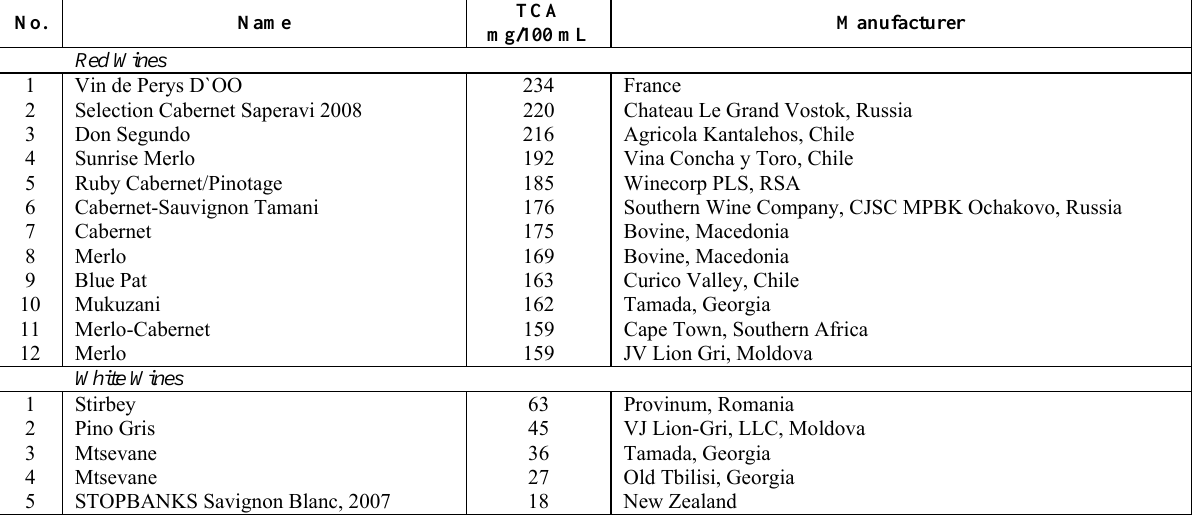
Table 10. Total Content of Antioxidants (TCA) in Red & White Wines (standard – quercetin).